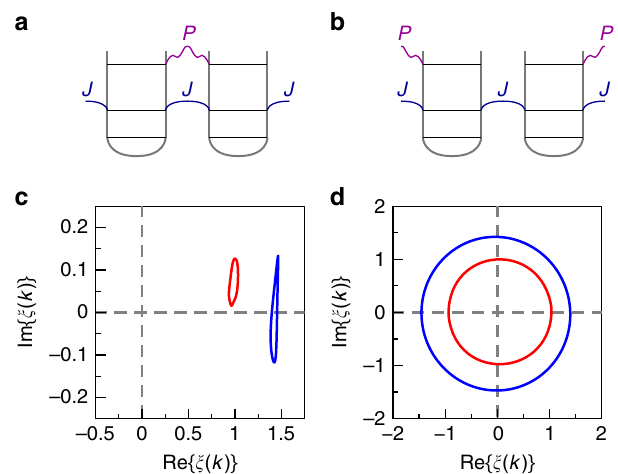
Fig. 3 Topological characterization of doublon modes. a , b Two possible choices of the unit cell. c , d The ratio of sublattice voltages U A ( k ) and U B ( k ), ξ ( k ) = U k ) ∕ U k ) plotted on a complex plane for the wave number k varied A ( B ( over the entire Brillouin zone. Blue and red lines correspond to numerical simulation and experiment, respectively. The winding numbers W = 0 ( c ) and W = 1 ( d ) correspond to the unit cell choices shown in a and b . The voltage distribution is measured for the system excited at the node (7,